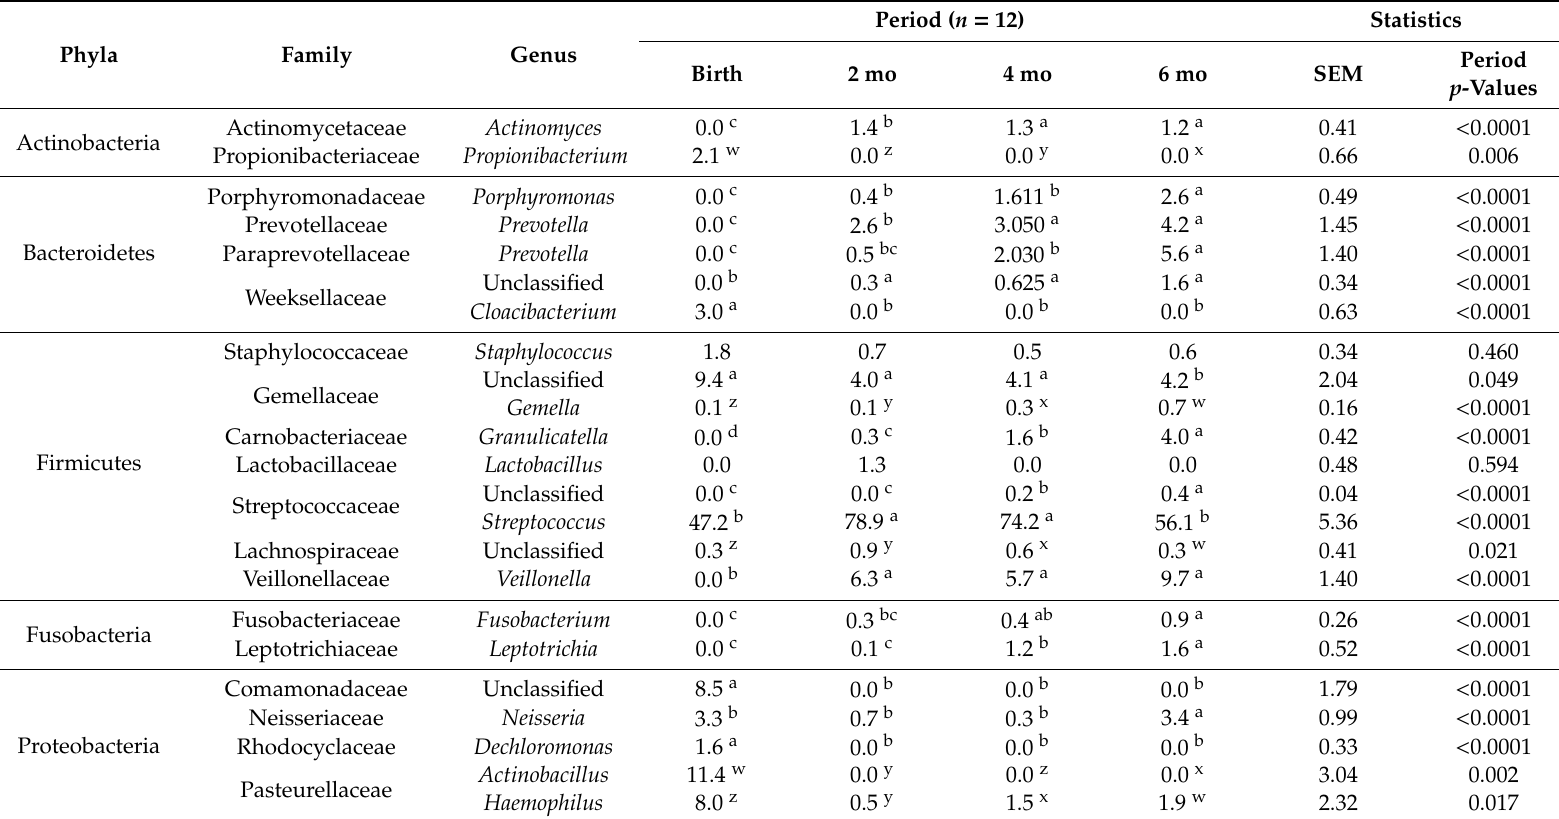
Table 2. Oral bacterial genera of infants over time (% of